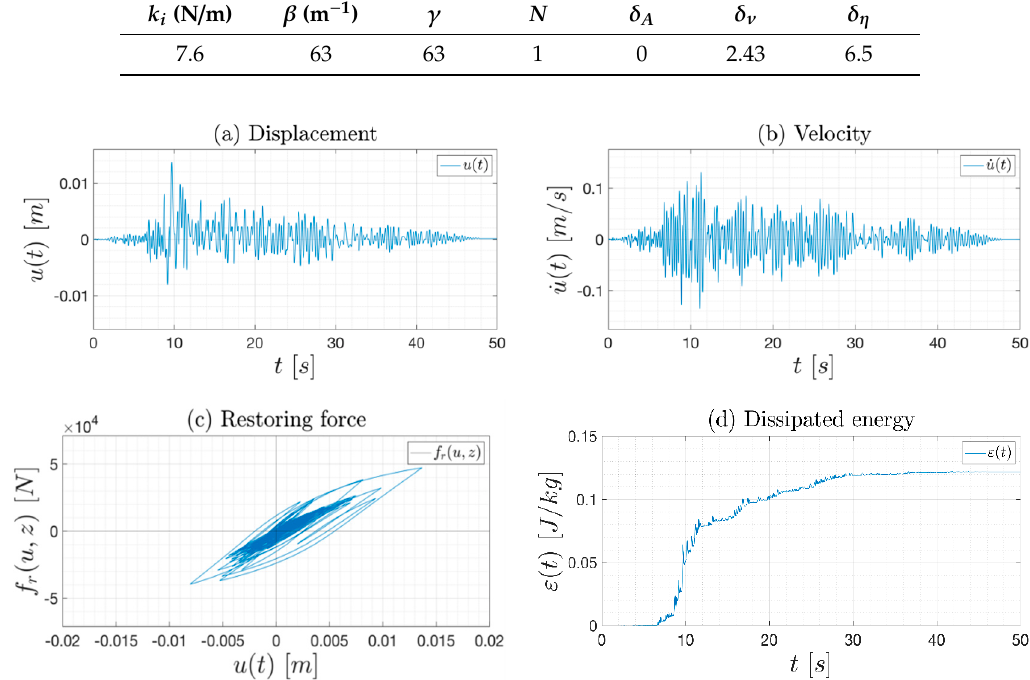
Figure 3. Simulated reference data: ( a ) response displacement of the Bouc–Wen–Baber–Noori (BWBN) oscillator; ( b ) response velocity of the BWBN oscillator; ( c ) hysteresis loop of the BWBN system; ( d ) total dissipated energy of the BWBN system (both elastic and hysteretic components of the restoring force are gathered), normalized with respect to the mass of the oscillator. Table 2. Uncertain parameters of the BWBN benchmark Table 1. Parameters of the BWBN model adopted for simulating the record data.